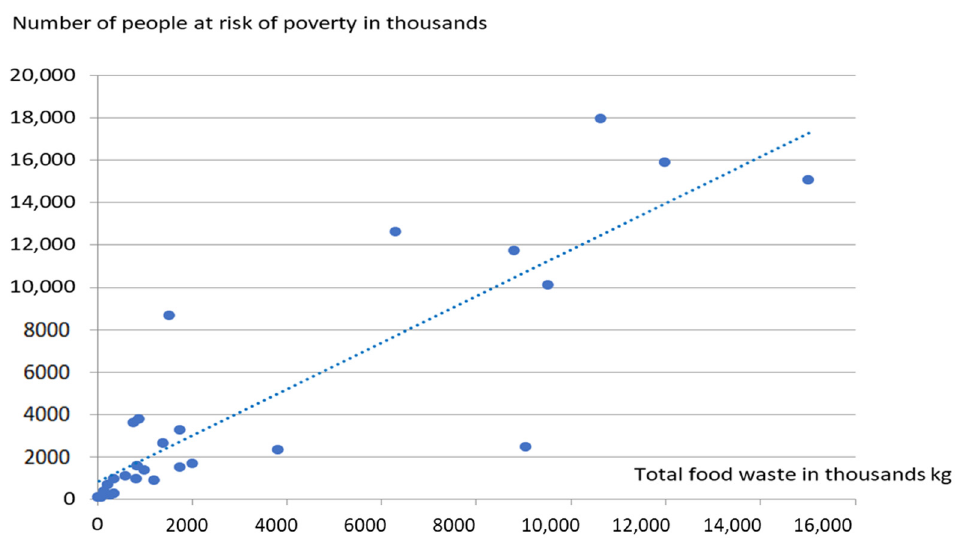
Figure 4. The relationship between the amount of food waste and the number of people at risk of poverty. Source: created by